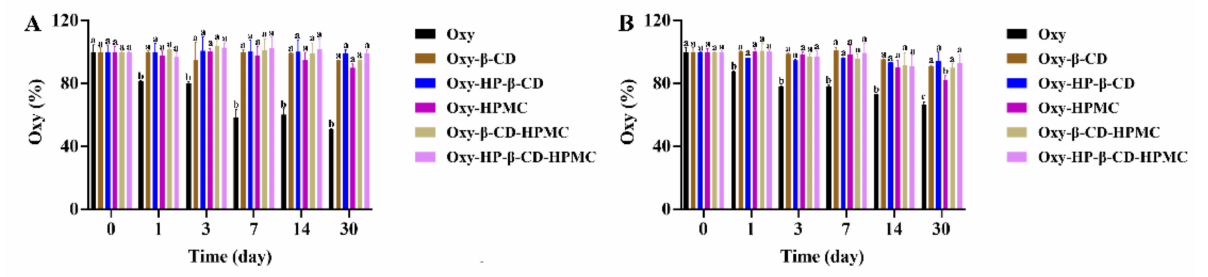
Figure 9. The percentage of remaining Oxy (both trans - and cis -forms) in Oxy, Oxy–HPMC, Oxy–CD, and Oxy–CD–HPMC solutions during 30 days of storage at 25 ◦ C without light was recorded by monitoring Oxy content with HPLC at a certain time interval ( n = 3, if no error bars are displayed, errors were smaller than symbols). Data were presented as mean ± SD, and significant differences compared to the pure Oxy group are shown with lower case letters a–d. All samples were stored in well-closed glass bottles. ( A ) Water; ( B ) acidic solution (pH 3.6). The lack of figures of the trans - and cis -forms here indicates that no cis -Oxy is formed in this treatment, and all remaining Oxy is in the trans structure.